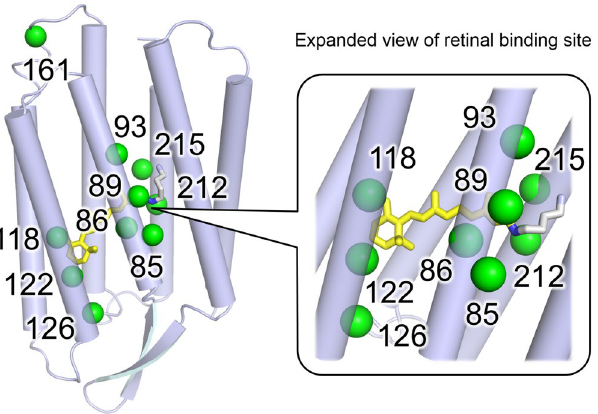
Figure 8. Top 10 active residues identified by the fitted statistical model. The positions of the active residues showing larger coefficient parameter values (green spheres) are mapped on the X-ray crystallographic structure of BR (blue, PDB code: 1BM1 33 ) with their numbers in the case of